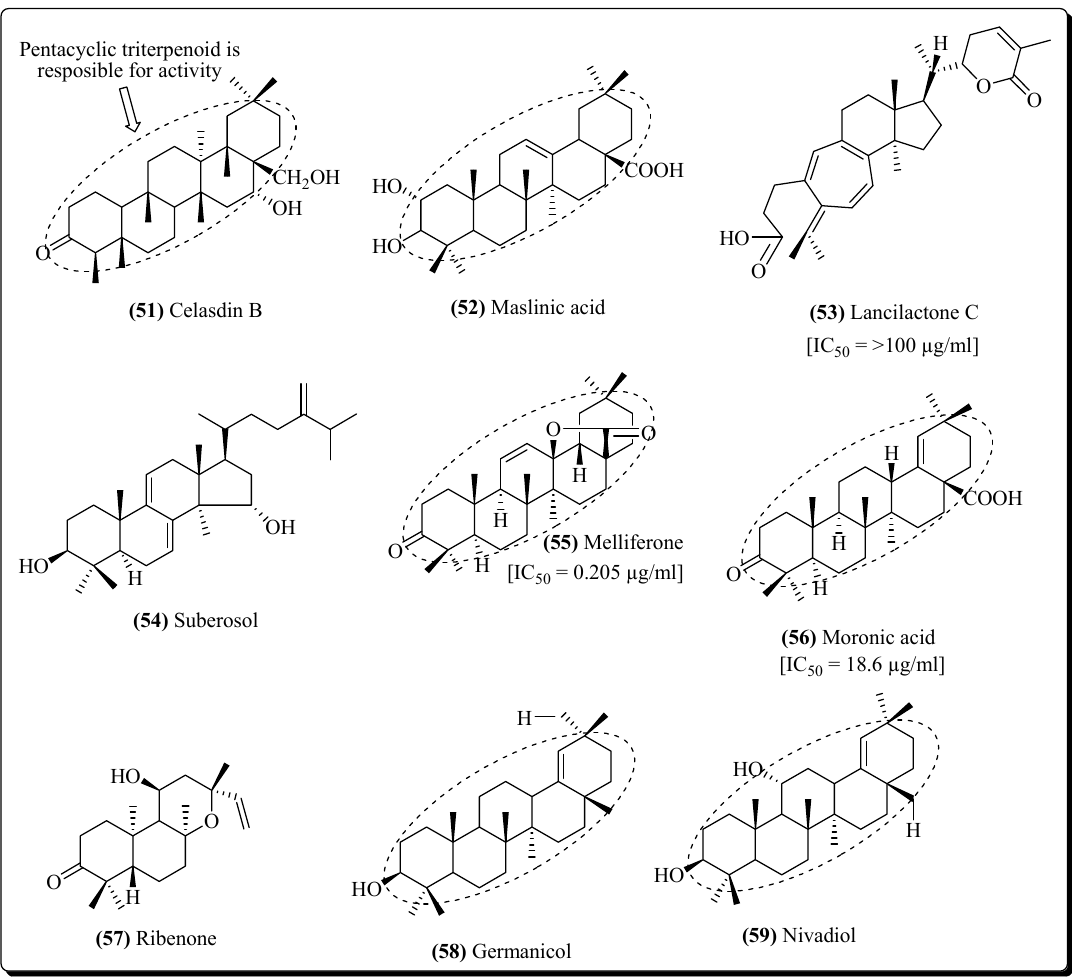
Figure 12. Potent terpenoids against HIV.